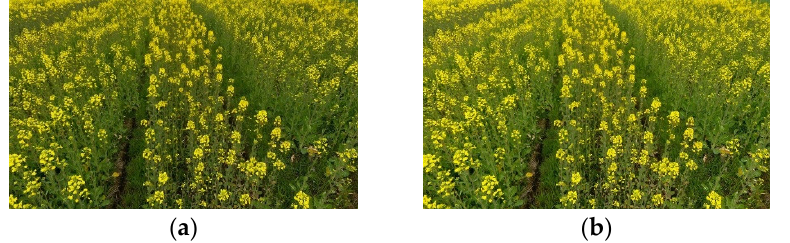
Figure 4. The OSR plant captured by UAV; ( a ) Under cloudy day condition; ( b ) Under sunny day condition.